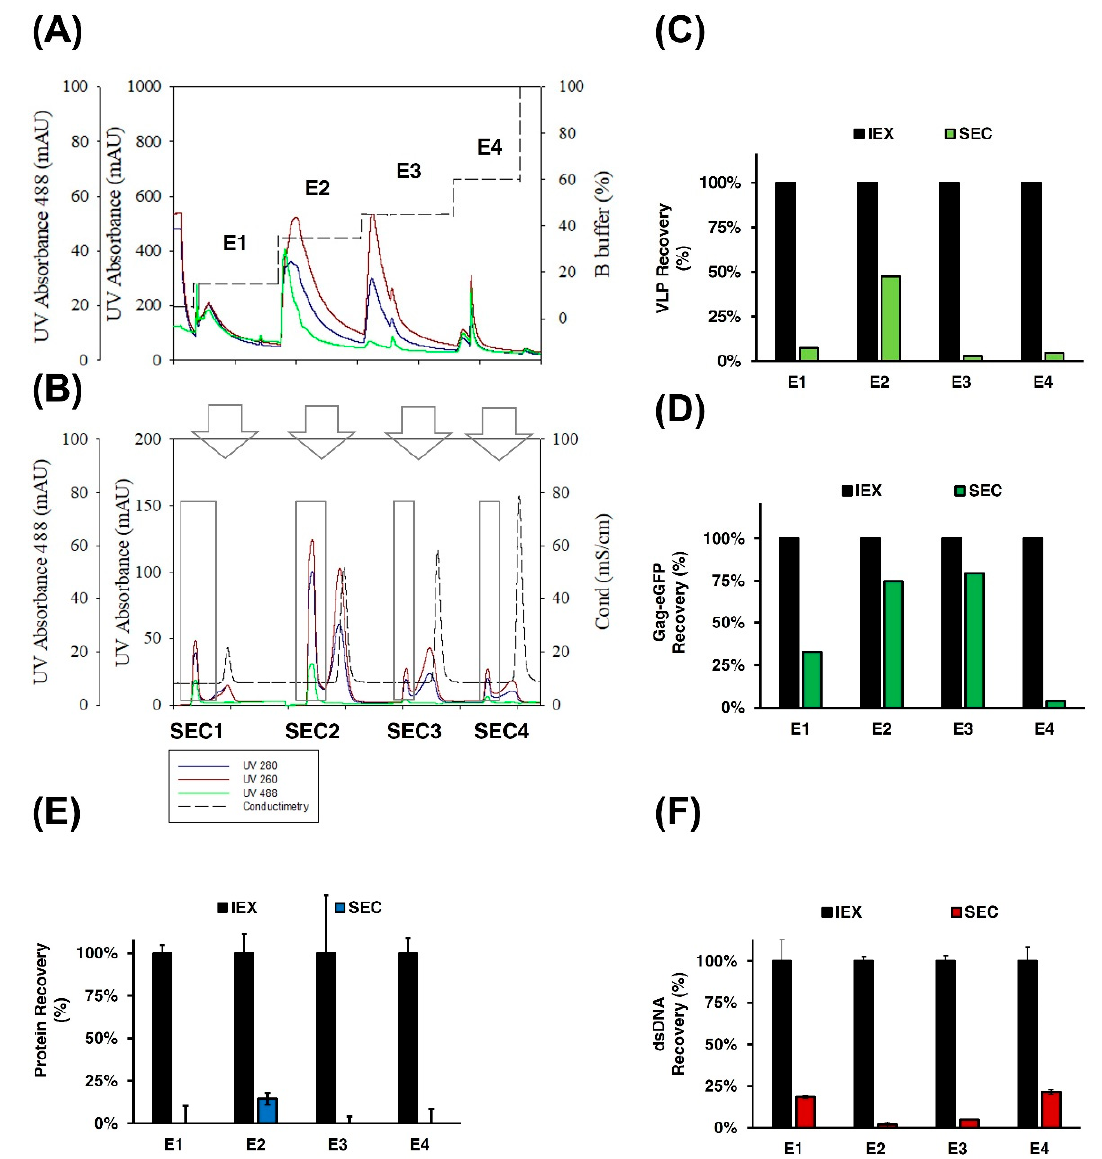
Figure 5. SEC of Gag-eGFP VLPs. ( A ) Chromatogram of IEX chromatography based on previous optimization protocol using a Mustang ® QXT. Gag-eGFP VLP supernatant produced in HEK 293 cell culture, clarified by flocculation and depth filtration was used as initial material. Equilibration buffer was 50 mM HEPES, 100 mM NaCl with pH 7.2, and step gradient of a total load of 283 mL eluted in step gradient of 15%–35%–45%–60% of B buffer corresponding to E1-E2-E3-E4 peaks. ( B ) Chromatogram of SEC from the four peaks obtained in IEX (SEC1-SEC2-SEC3-SEC4, respectively). A 43 mL Sepharose 4 Fast Flow (4FF) packed column was used. SEC column was equilibrated with 20 mM NaH2PO4, 50 mM NaCl, 2 mM MgCl 2 , 2% sucrose pH 7.5. The recovery of VLPs ( C ), Gag-eGFP polyprotein ( D ), total protein ( E ), and dsDNA ( F ) was assessed for each